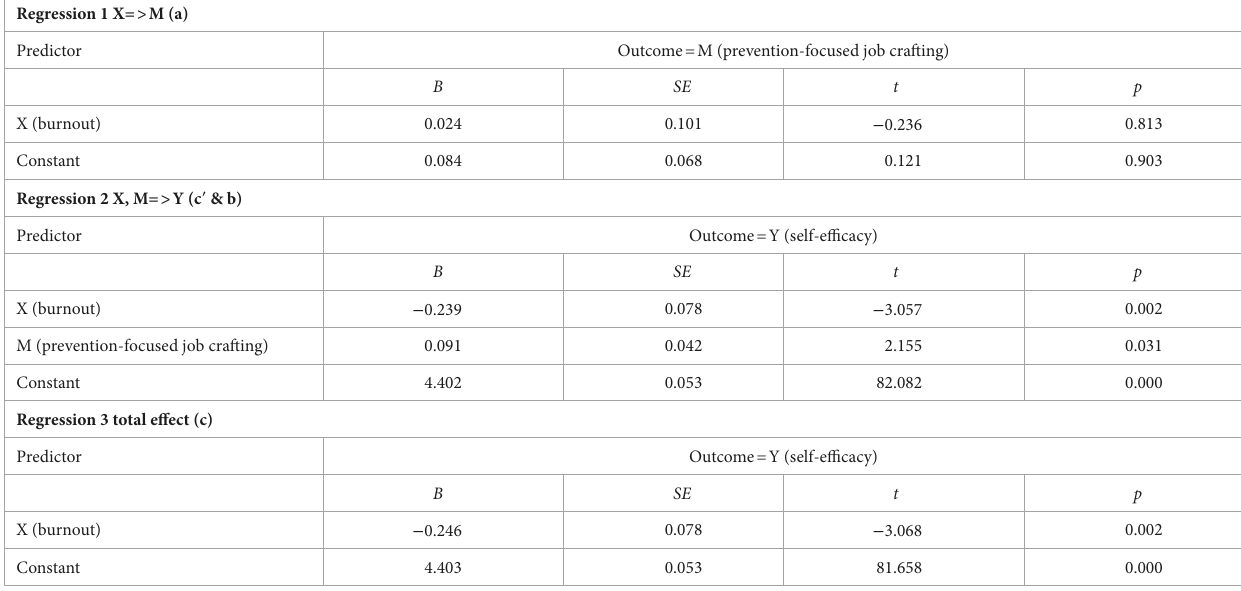
TABLE 2 Analysis of prevention-focuses job crafting mediation on the influence of burnout on self-efficacy (simple mediation model for prevention- focuses job crafting). Regression 1 X= > M (a)